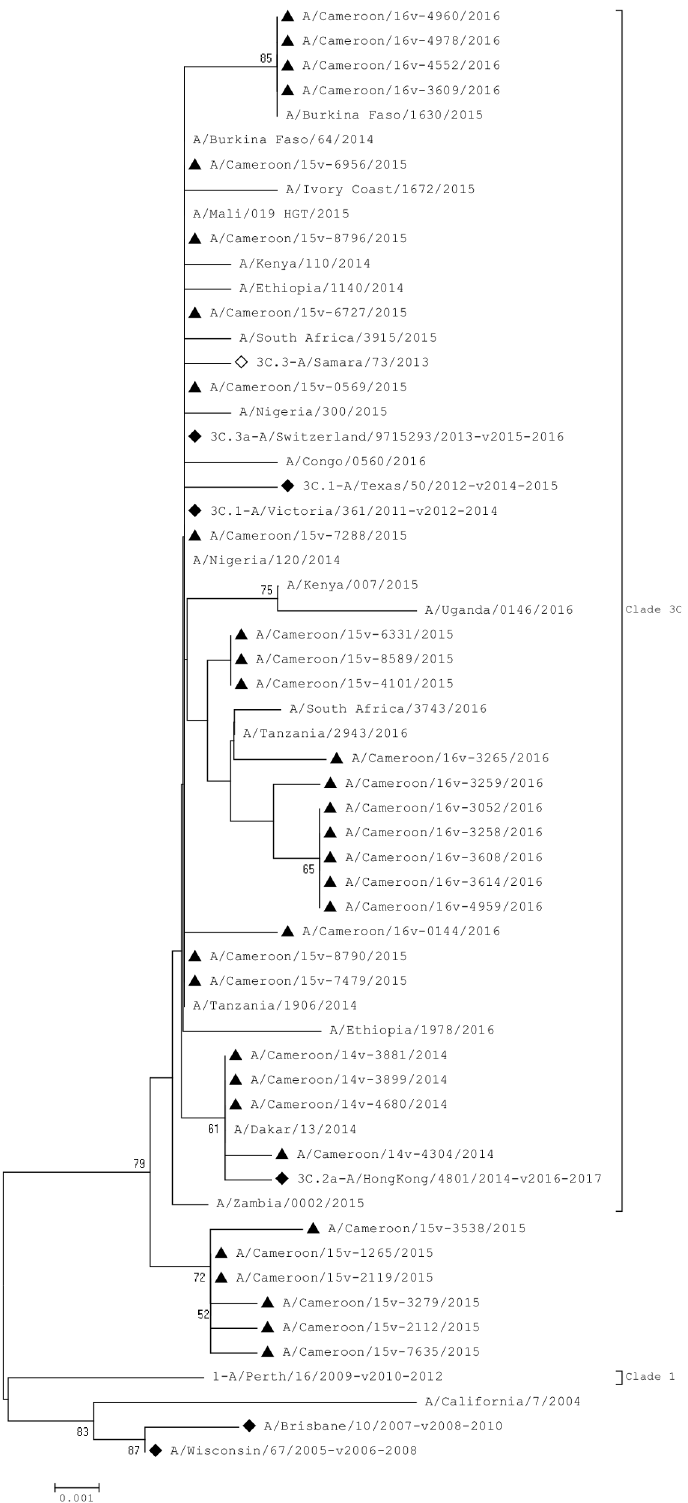
Fig 3. Phylogenetic analysis of M nucleotide sequences of influenza A(H3N2). ^ represent reference strains of known clades, ♦ represent the Northernhemisphere vaccine strains recommended by WHO and ▲ representCameroonian